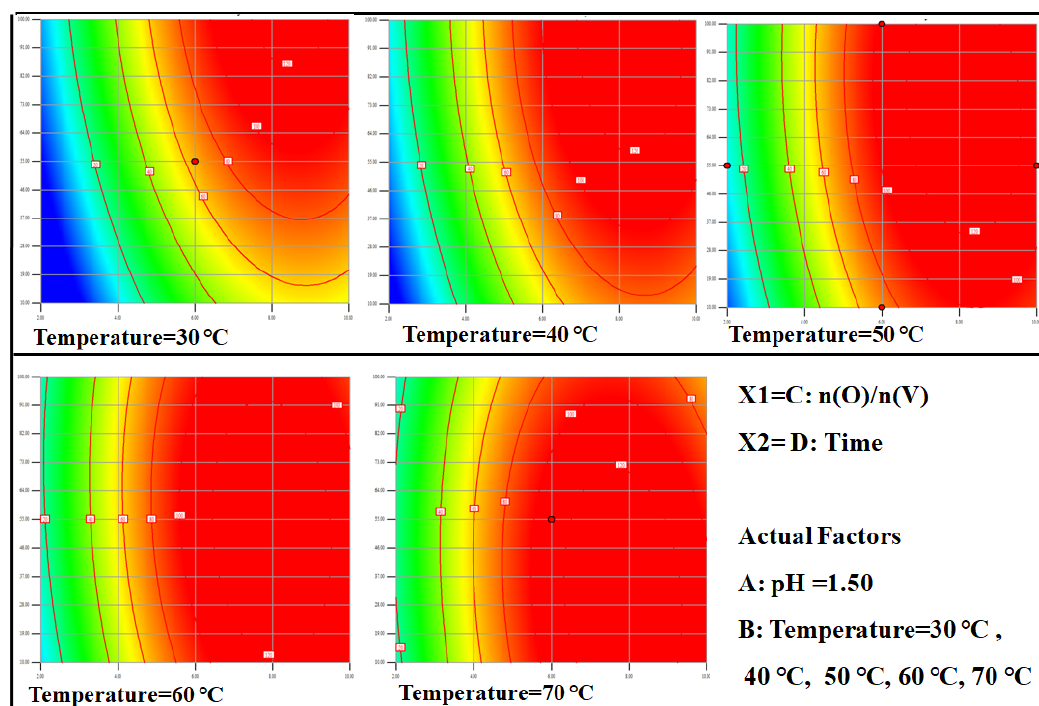
Figure 11. Response surface plots for factors (C to D).